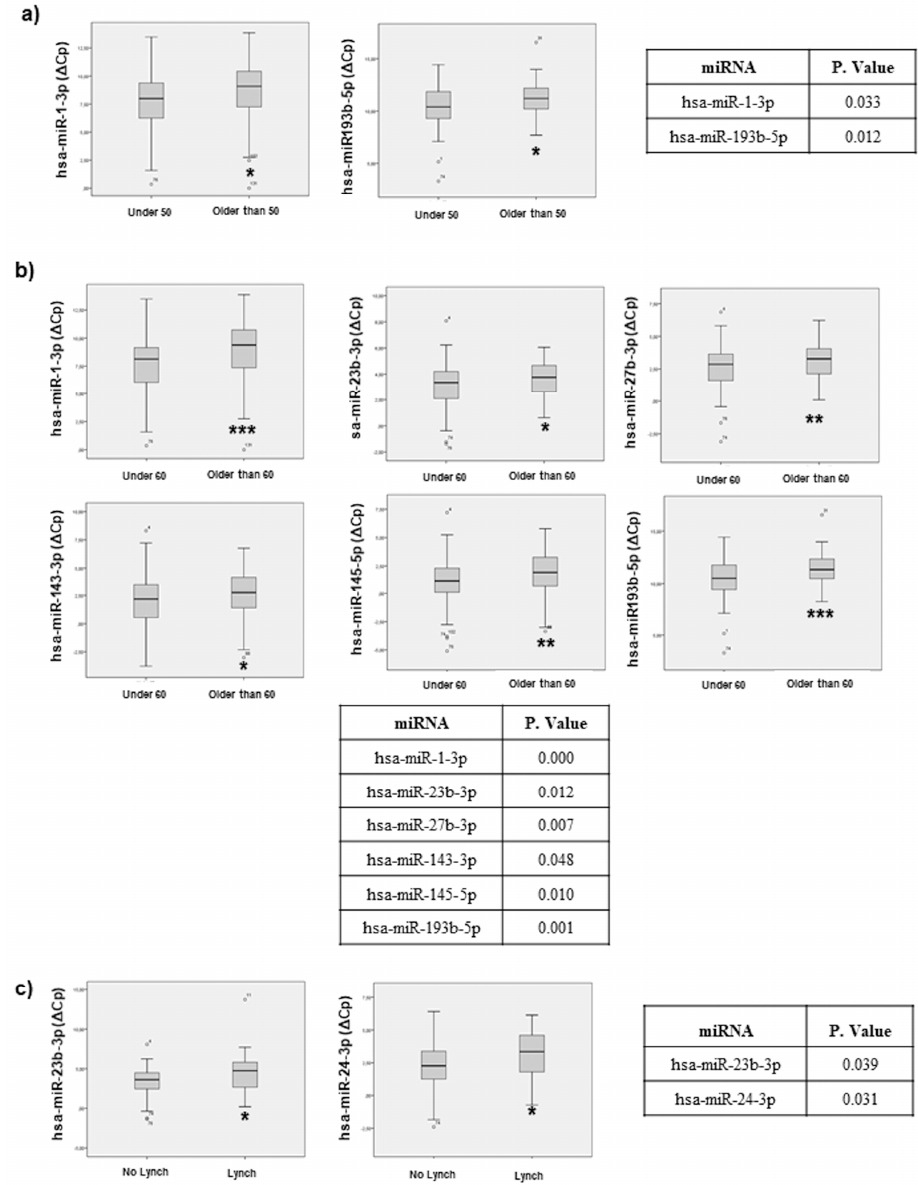
Figure 2. Statistical correlation, of the selected miRNAs, with age and Lynch condition. Statistical analysis using SPSS 19.0 between miRNAs levels expressed as delta crossing threshold (DCT) was performed and data regarding correlation with age ( a ) under 50, ( b ) under 60 and ( c ) Lynch condition are presented. Only miRNAs exhibiting a statistically significant correlation are shown. Data are presented as median and interquartile range with: * p < 0.05, ** p < 0.01, *** p <